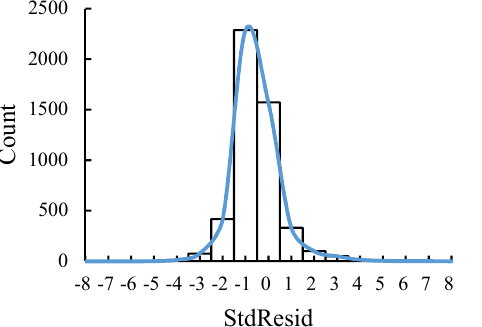
Figure 5. The GWR model’s StdResid values in December, 2016.